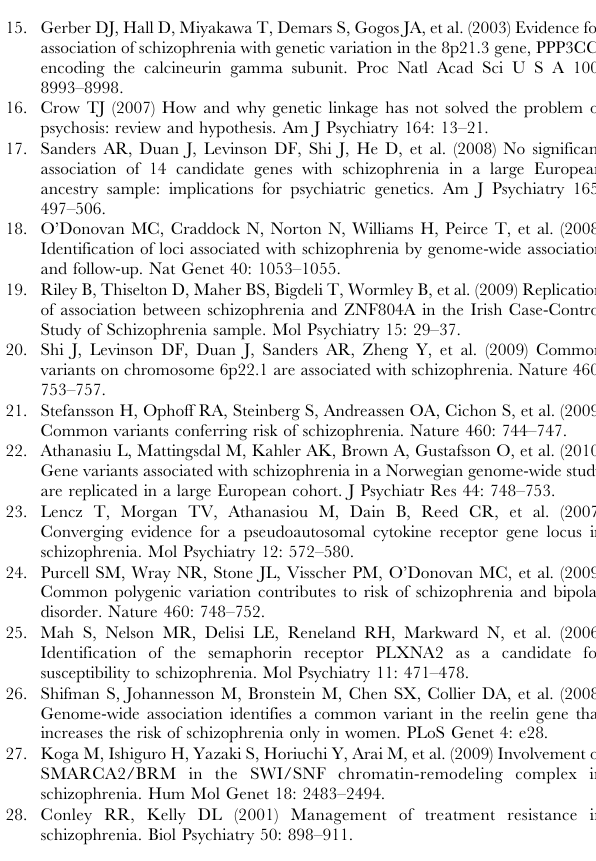
Table S7 Adjustment of the top SNPs for drinking and inclusion of 20 principal components as covariates in logistic regression. distance using